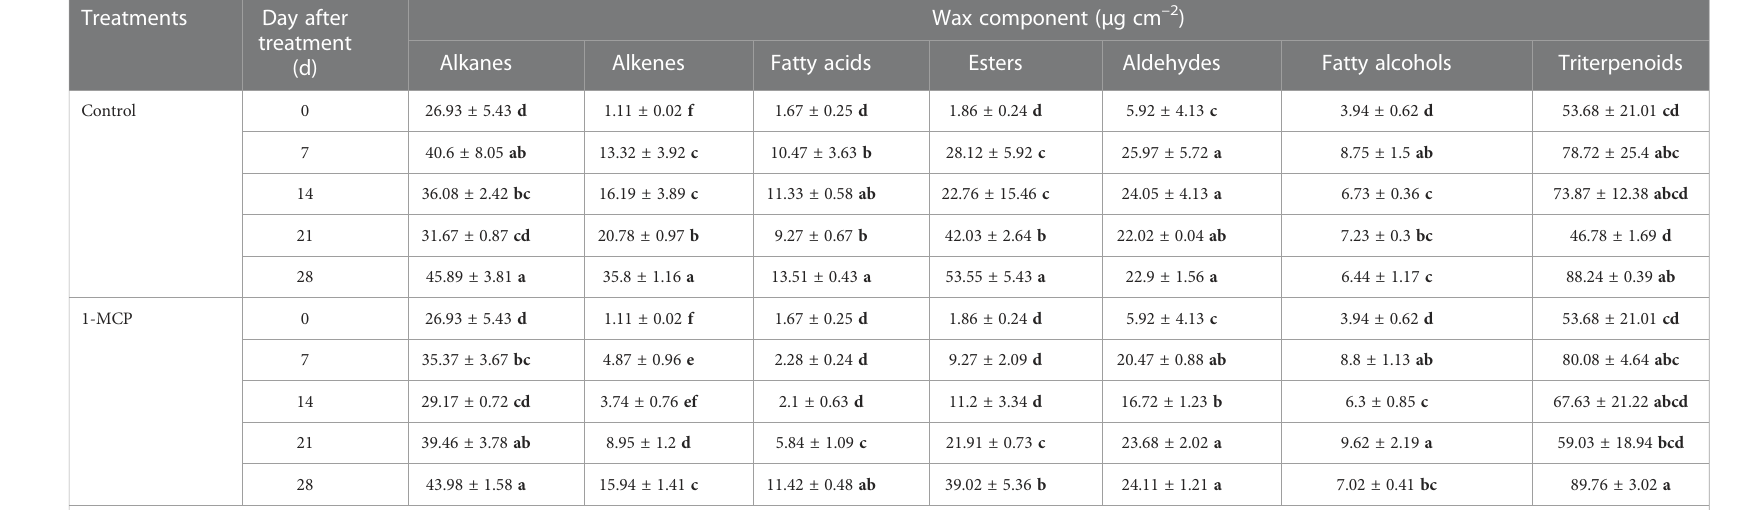
Wax component (µg cm – 2 )